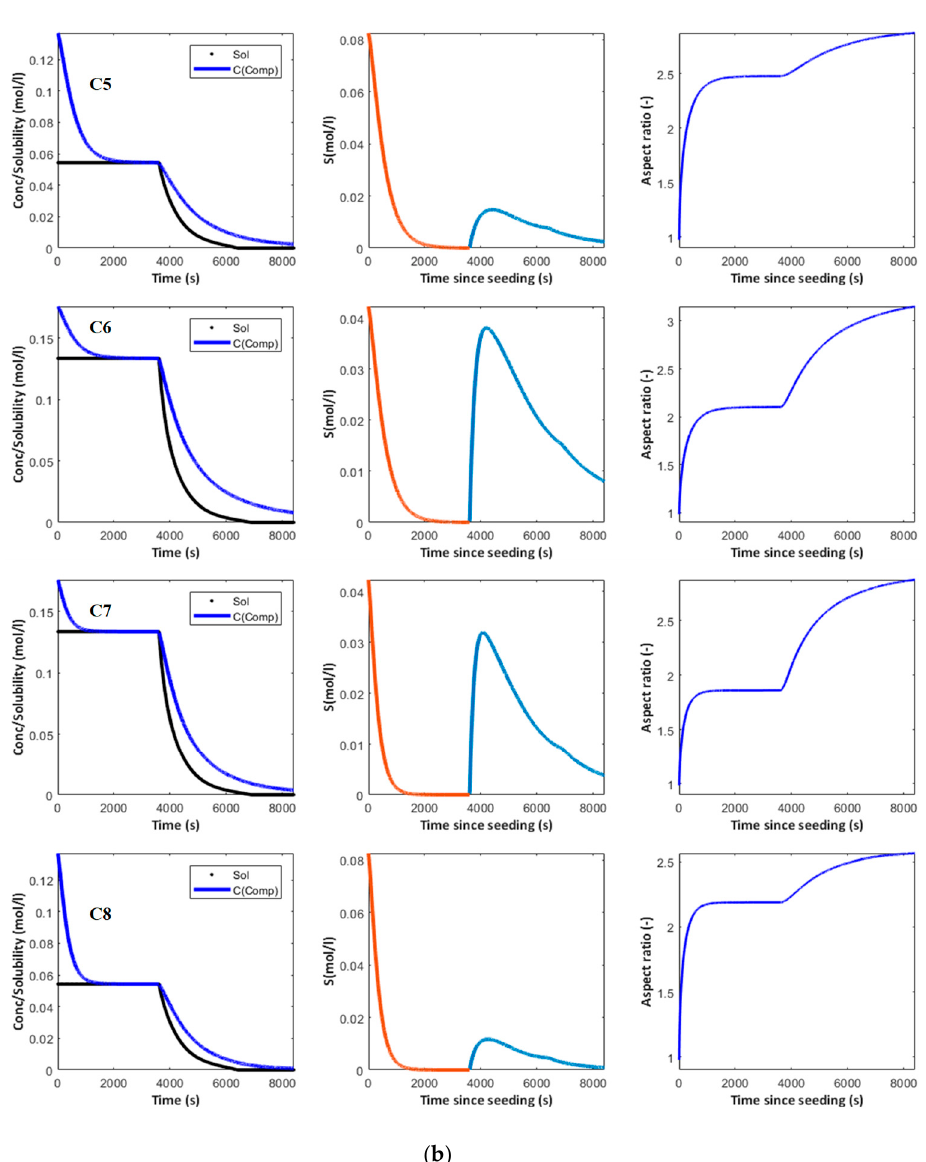
Figure 6. ( a ) Computation of transient aspect ratio and particle size distribution. ( b ) Computation of transient aspect ratio and particle size distribution.